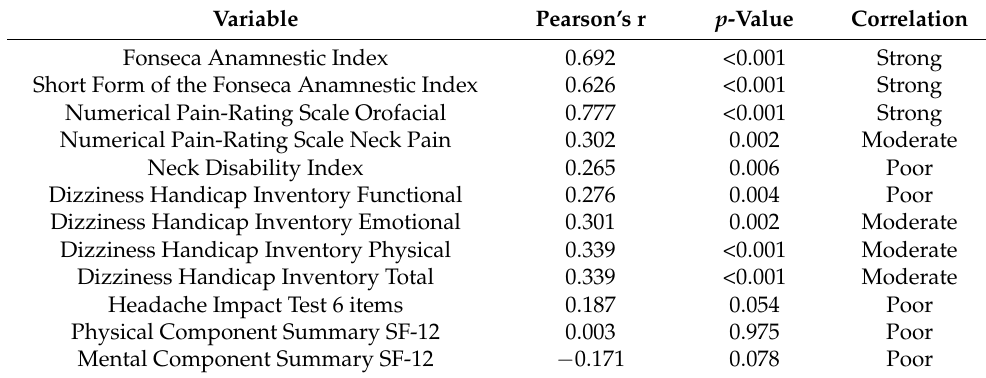
Figure 1. Limits of concordance by Bland–Altman plot. Table 3. Concurrent validity of the Helkimo Clinical Dysfunction Index with other specific and generic instruments.